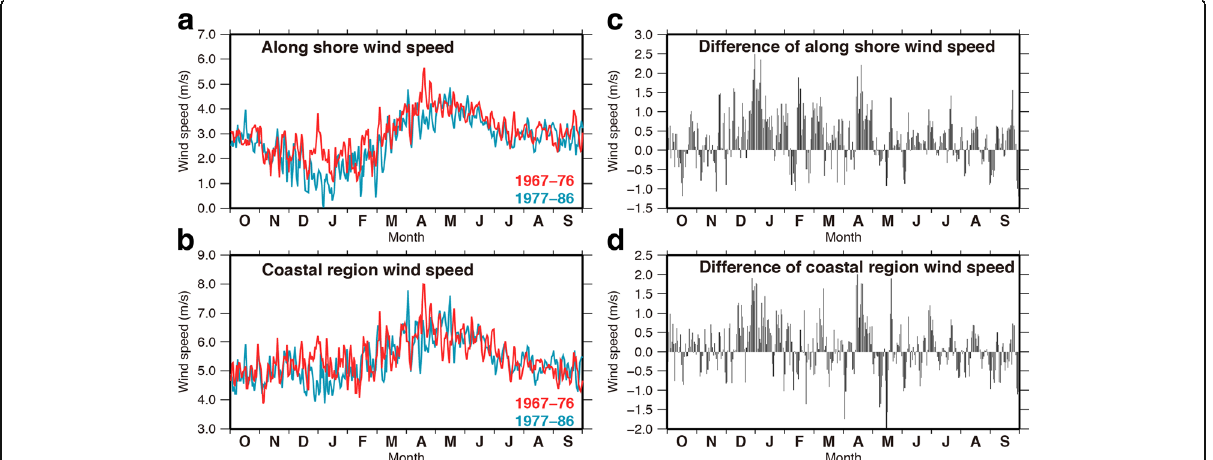
Fig. 19 Seasonal changes of wind used as input to the historical simulation. a Alongshore wind speed within 10 km of the coastline, b absolute wind speed in the coastal region, c difference of the alongshore wind speed from 1967 – 1976 mean to 1977 – 1986 mean, and d difference of the absolute wind speed in the coastal region from 1967 – 1976 mean to 1977 – 1986 mean. In a and b , red line denotes value averaged over 1967 to 1976 and blue line denotes value averaged over 1977 to 1986. The values from October to December are grouped with the following year